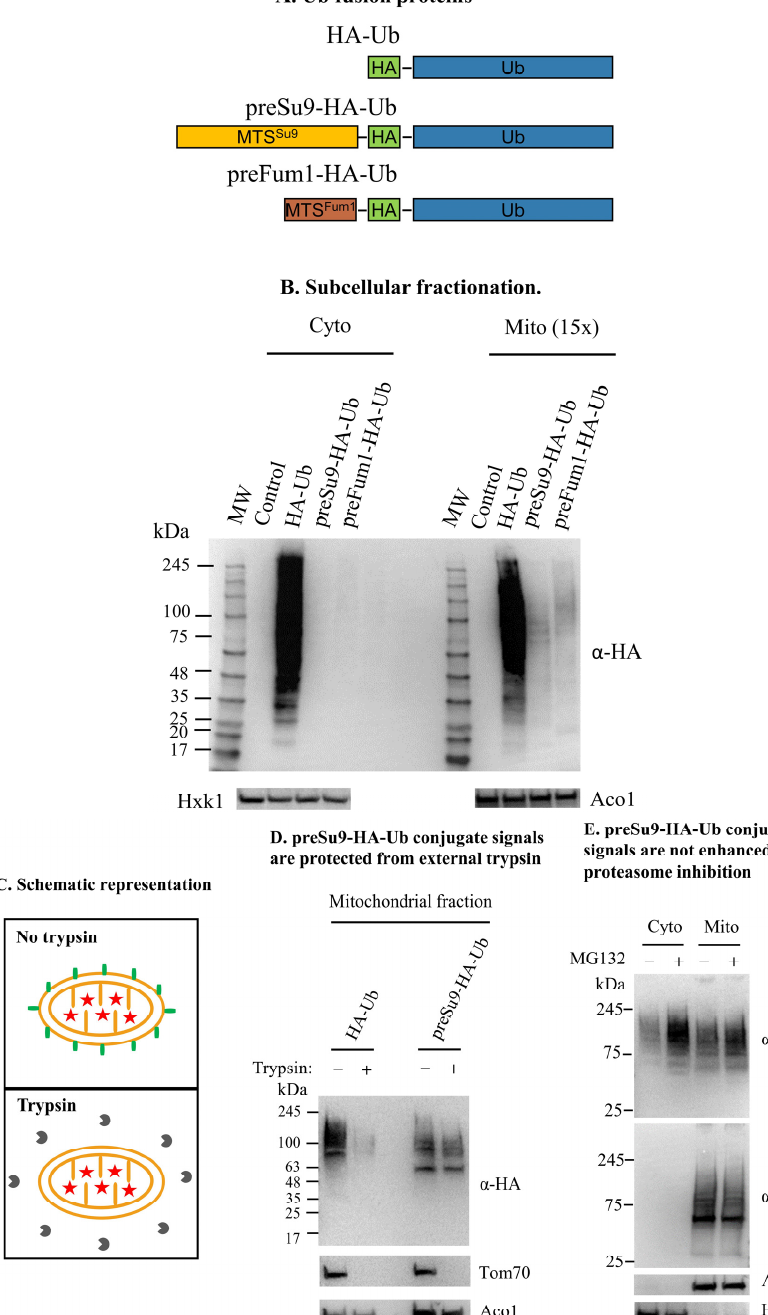
Figure 3. Conjugates of mitochondrially directed MTS-HA-Ub are detected in mitochondria. ( A ) Schematic representation of ubiquitin fusion protein constructs. Three ubiquitin fusion proteins were constructed, including an N-terminal HA-tagged ubiquitin (HA-Ub) and two mitochondrially directed HA-Ub by adding the presequence of subunit 9 of F0-ATPase of Neurospora crassa (1–69 aa) or Fum1 (1–27 aa) in front of HA-Ub, which are respectively named preSu9-HA-Ub and preFum1-HA-Ub. ( B ) Detection of HA-Ub in mitochondria by western blot. Subcellular fractions were prepared from glucose-grown BY4742 Δ pdr5 cells expressing HA-Ub, preSu9-HA-Ub, preFum1-HA-Ub, or empty plasmid (Control). Mitochondrial fractions (Mito) corresponding to 15 Χ cells and cytosolic fractions (Cyto) corresponding to 1 Χ cells were subjected to western blot for HA- marked ubiquitin conjugates detection using a-HA antibodies. Hxk1 and Aco1 antibodies served as loading and fractionation controls. ( C ) Schematic representation of the trypsin treatment of isolated mitochondria. The mitochondrial membranes ( ), an outer membrane protein exposed to trypsin ( ), a matrix protein protected inside mitochondria ( ), and trypsin ( ) are indicated. ( D ) preSu9-HA-Ub conjugates signals are protected from external trypsin. Mitochondrial fractions were prepared from cells expressing HA-Ub or preSu9-HA-Ub, and mitochondrial fractions with and without trypsin treatment were subjected to western blot using α -HA antibodies. Tom70, a cy- tosol-facing mitochondrial outer membrane protein, was used as a marker exposed to the trypsin treatment, and Aco1 is a protected mitochondrial matrix marker. ( E ) preSu9-HA-Ub conjugates sig- nals are not enhanced by proteasome inhibition treatment. Cytosolic (Cyto) and mitochondrial (Mito) subcellular fractions prepared from preSu9-HA-Ub expressing cells in the presence or ab- sence of MG132 treatment were subjected to western blot. Detection of general and HA-tagged ubiq- uitin conjugates signals employed α -Ub and α -HA antibodies, respectively. Cytosolic marker Hxk1 and mitochondrial marker Aco1 are indicated. 3.2.2. Conjugate Signals of preSu9-HA-Ub in Isolated Mitochondria Are Resistant to Ex- ternal Trypsin Treatment Unlike peripheral mitochondrial proteins and mitochondrial outer membrane (MOM) proteins facing the cytosol, preSu9-HA-Ub conjugates from isolated mitochondria are assumed to be localized in the matrix and resistant to trypsin treatment of whole